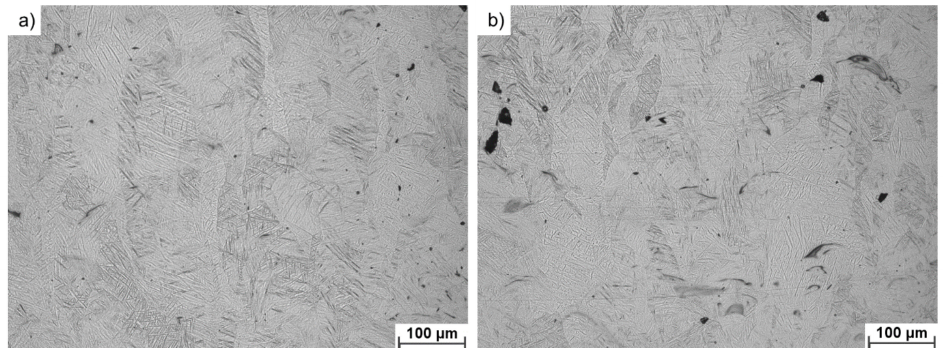
Figure 11. Representative micrographs of investigated 3D-printed materials: ( a ) FRESH and ( b ) USED powder showing no visual microstructural